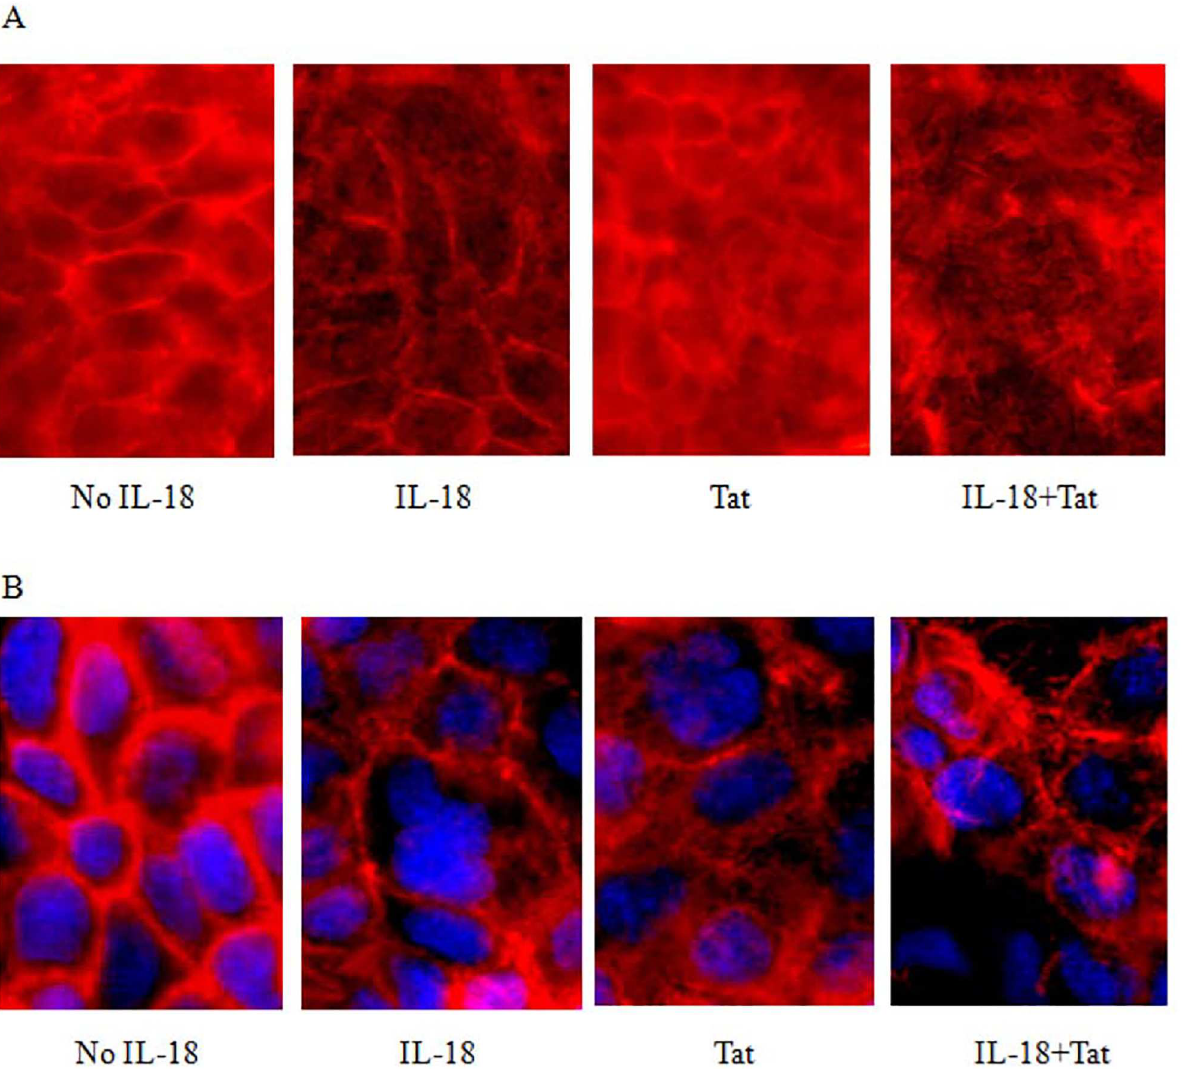
Fig 9. Effects of IL-18 on the expression and distribution of F-actin. The cells HT29 ( A ) and Caco2 ( B ) monolayers were treated with IL-18 and/or with Tat for 24 hours. The cells were washed with PBS, permeabilized, stained with Phalloidin red and DAPI. The cells were examined under a fluorescent microscope and photographed. The treatment with IL-18 causes a reduction in the expression whereas the treatment with Tat causes a more diffused expression of F-actin.